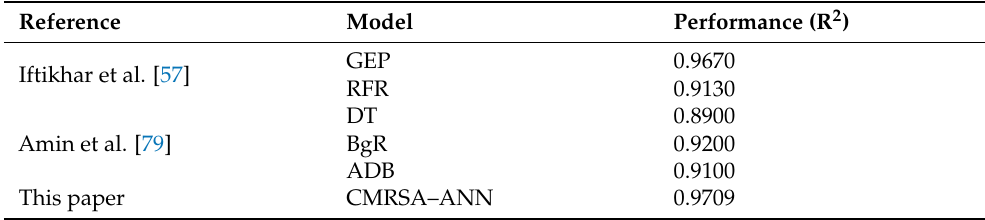
Table 7. Performance comparison of previous works and the proposed model.